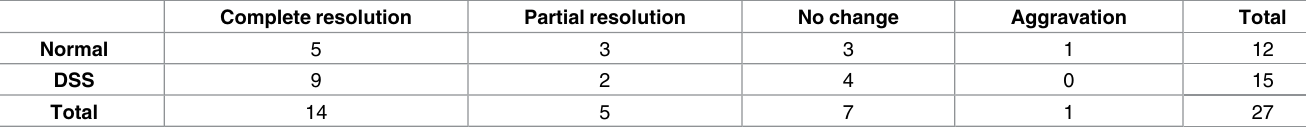
Table 2. Association between surgical outcome and sigmoid sinus